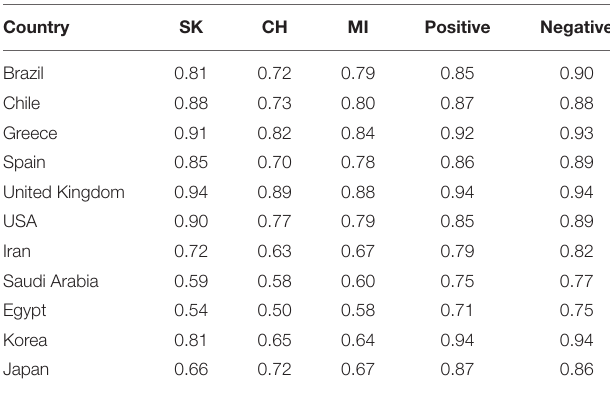
TABLE 2 | Composite reliability values of factors sorted by country.